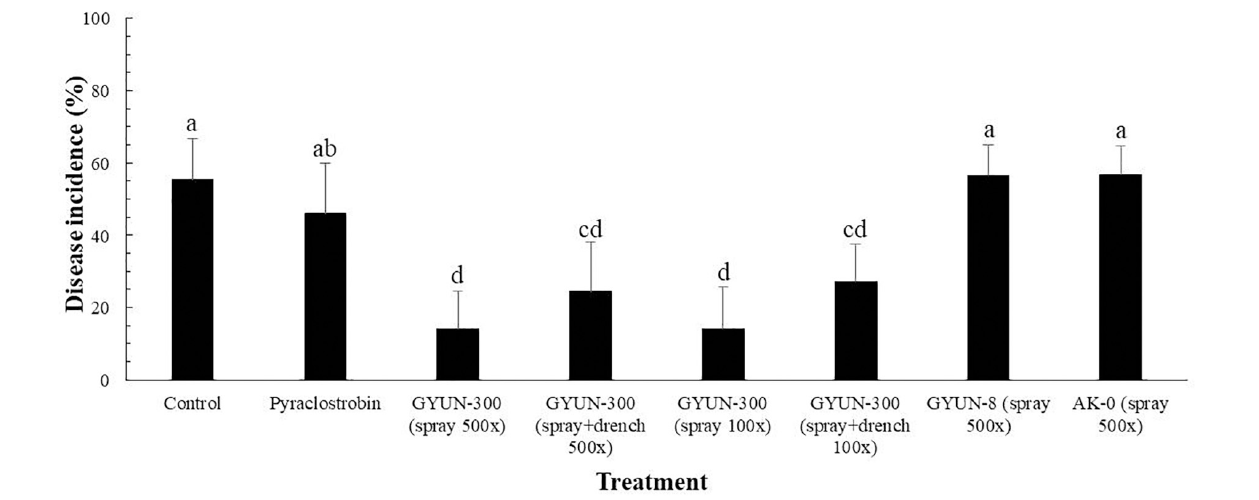
FIGURE 8 | Effect of GYUN-300 treatment on disease suppression of anthracnose caused by Colletotrichum acutatum under field conditions. Various treatments of GYUN-300 were compared with the chemical controls and non-treated control. Bars with the same letters do not differ significantly between each other according to the least significant difference (LSD; p <